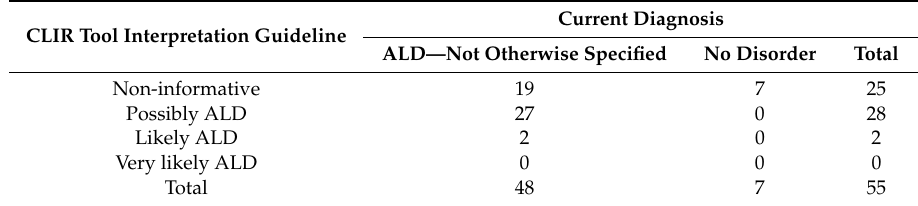
Table 1. Comparison of CLIR ALD tool run interpretation guideline results with current diagnosis for ALD screen positive individuals with variant of uncertain significance (VUS).